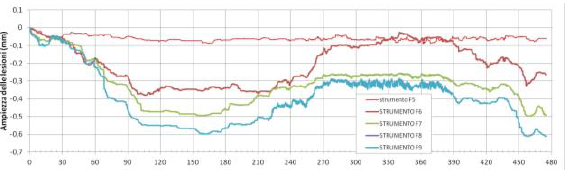
Figure 4. Trend of the four instruments installed in Sala Verdi: on x axis time (days) is plotted and on y the crack width